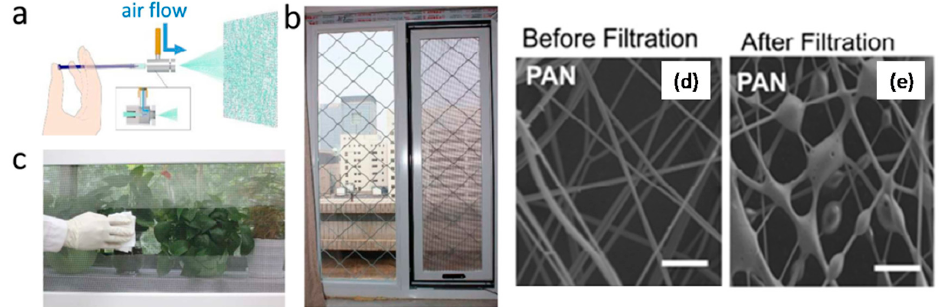
Figure 13. Real window based PM filtering performances. ( a ) Practical model of the blowspinning setup for window screen coating; ( b ) Real window coated with PAN-NFs; ( c ) Successful wiping of nanofibers from the window screen with a tissue paper and SEM images of PAN-NFs ( d ) before and ( e ) after filtration.